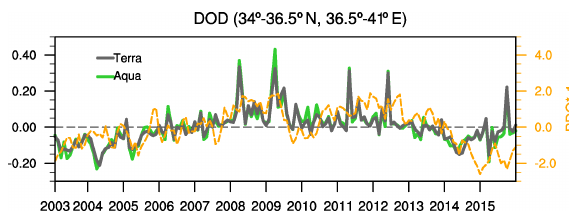
Figure 1. Monthly time series of Aqua (green) and Terra (grey) DOD indices averaged over Syria (see Fig. 2 for domain) and PDO index (orange; multiplying by − 1 to show its negative correlation with the DOD